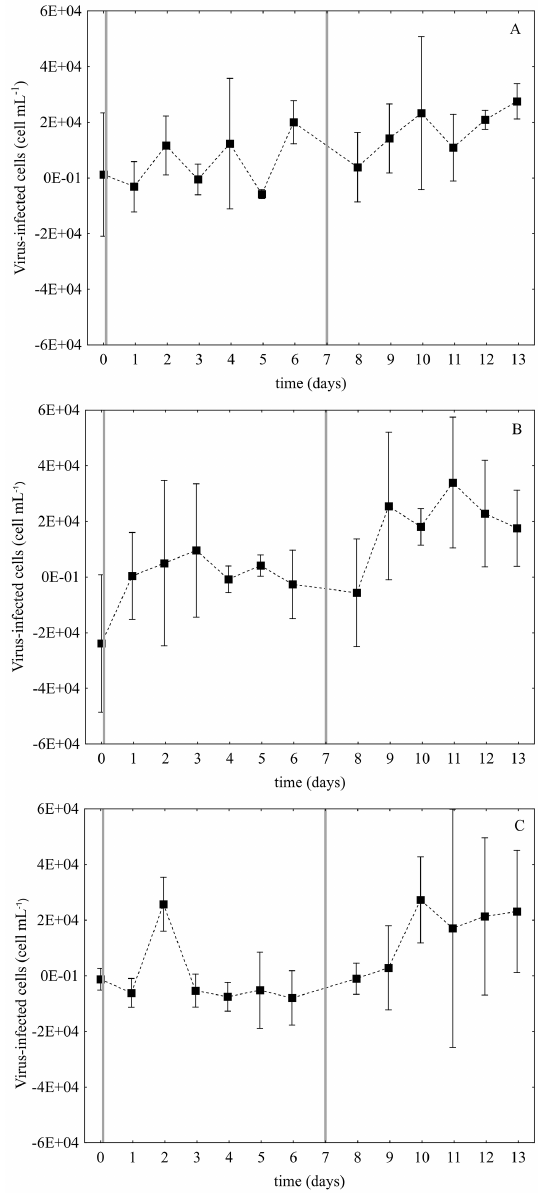
Figure 9. Theoretical calculation of viral infected bacterial abun- dance (cell mL − 1 , mean ± standard deviation of three replicate mesocosms) based on the dust-induced changes in VA (VAdust – VAcontrol) at surface (a) , 5m (b) and 10m (c) depth during the DUNE-R experiment and a conservative burst size of 20 (Parada et al., 2006). Grey vertical bars represent the dust